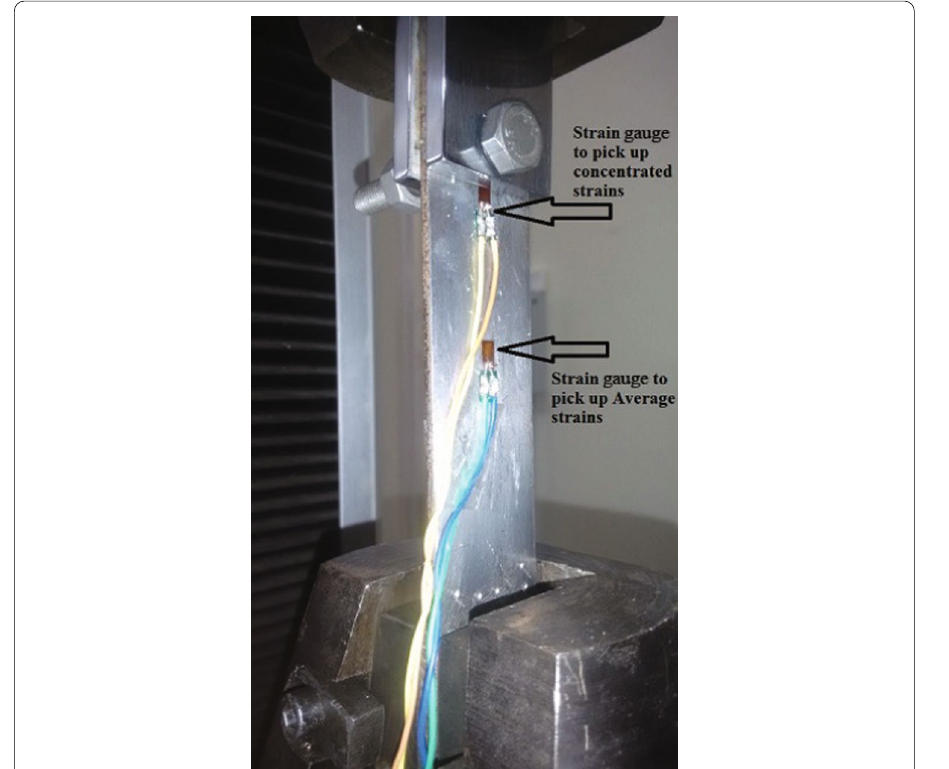
Fig. 10 Strain gauge locations on specimen for St. Venant’s